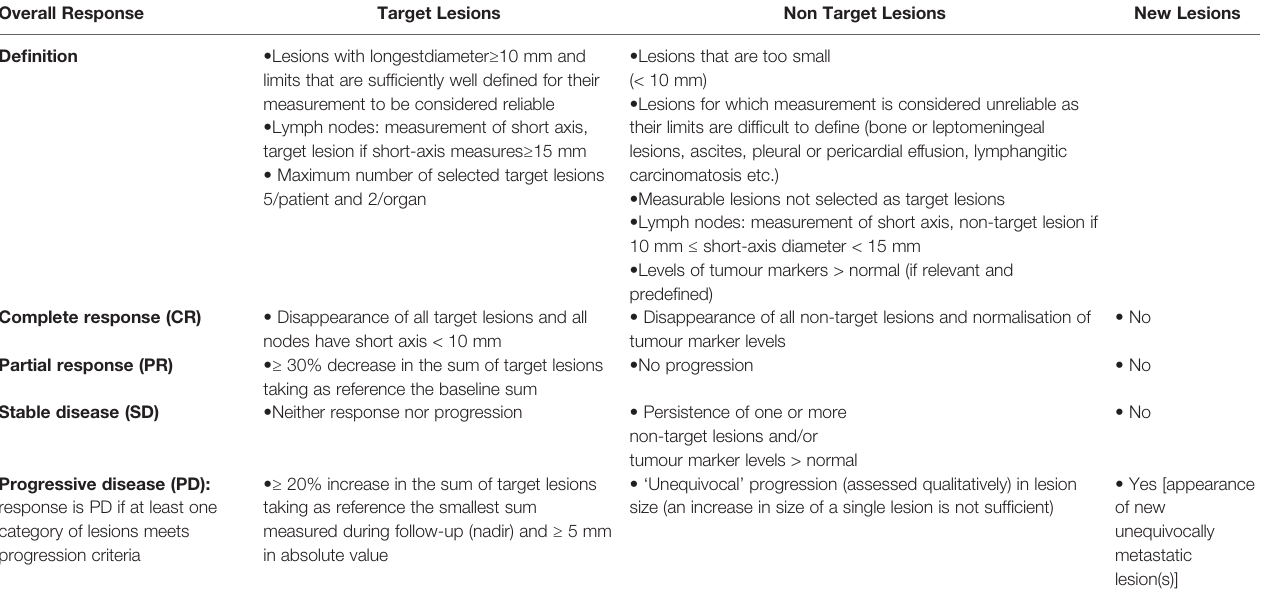
TABLE 1 | RECIST categories of